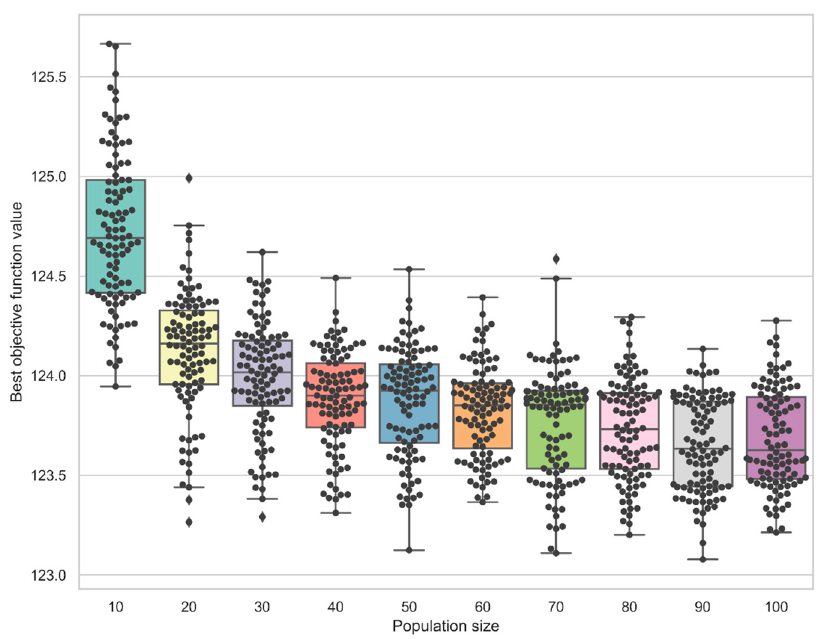
Figure 5. Boxplot diagrams of the resultant objective function values ϕ ( x ) for a number of population sizes ( s = var , F = const )